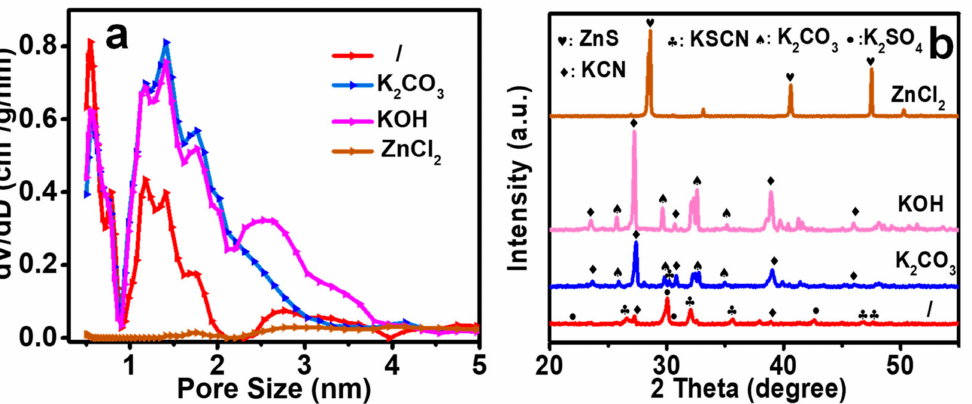
Figure 1. ( a ) The distribution of pore sizes for NSC, which were produced by being thermally induced using different inorganic activator, ( b ) XRD patterns for the unwashed NSC produced by being thermally induced using different inorganic activator. The activation conditions were set to be 700 ◦ C, and the mass ratio of inorganic activator: KSCN: biomass was